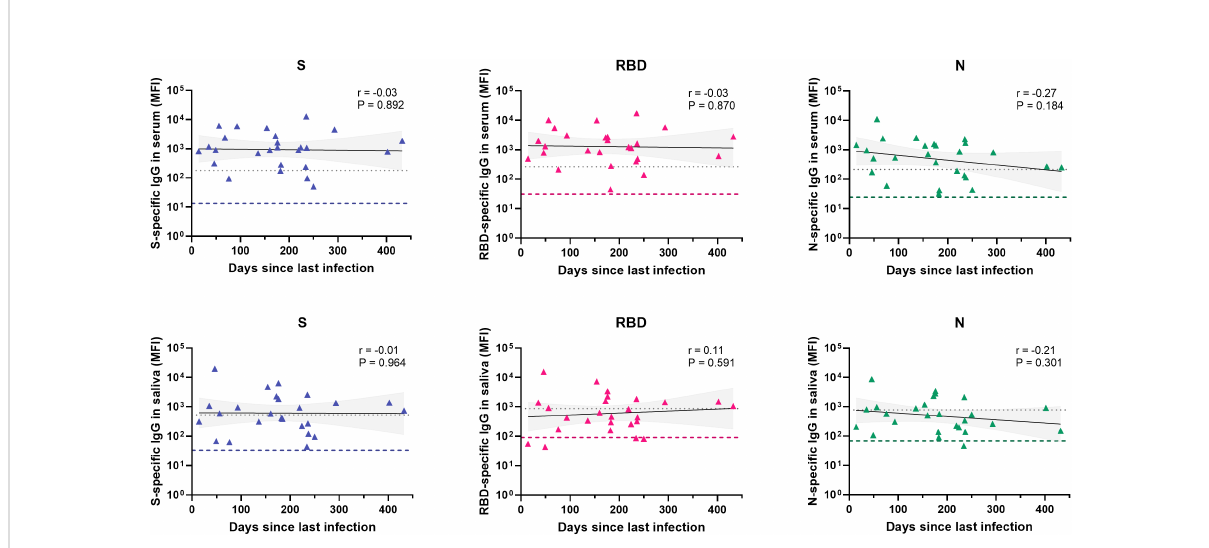
FIGURE 2 Antibody levels over time for different antigens in serum and saliva after infection. Levels of S-, RBD- and N-speci fi c antibodies in serum (n = 26) and saliva (n = 26) of unvaccinated children with con fi rmed SARS-CoV-2 infection and known time of infection (total n = 27). Within each graph, each data point is a different individual. The black line represents a linear regression and the grey area the 95% con fi dence intervals. Pearson correlations were performed and the coef fi cient (r) and the P-value are shown for each graph. The grey dotted line indicates the assay cut-off and the colored dashed line represents the median MFI of all children in the unknown exposure group as a reference. S, spike; RBD, receptor binding domain of the spike; N, nucleocapsid; MFI, median fl uorescence